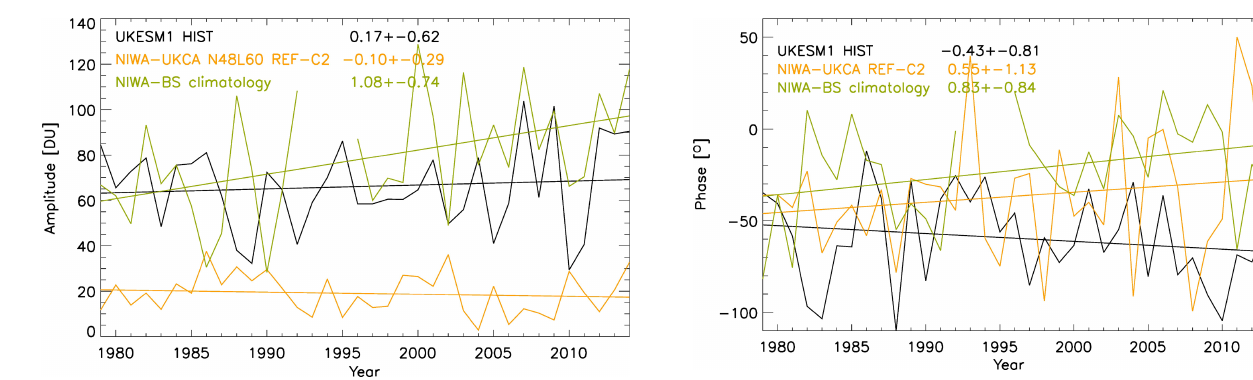
Figure 25. Amplitude A [DU] of the zonal asymmetry in total- column ozone at 60–70 ◦ S in October. Green: NIWA–Bodeker Sci- entific total-column ozone climatology vn 3.4. Orange: the model used by Dennison et al. (2017), NIWA-UKCA. The data repre- sent the average of five CCMI REF-C2 simulations by their model. Black: UKESM1. The data represent the average of two CMIP6 “historical” simulations (Sellar et al., 2019). Straight lines are linear regression fits. The numbers represent mean trends and associated 95% confidence intervals (DUyr − 1 ).